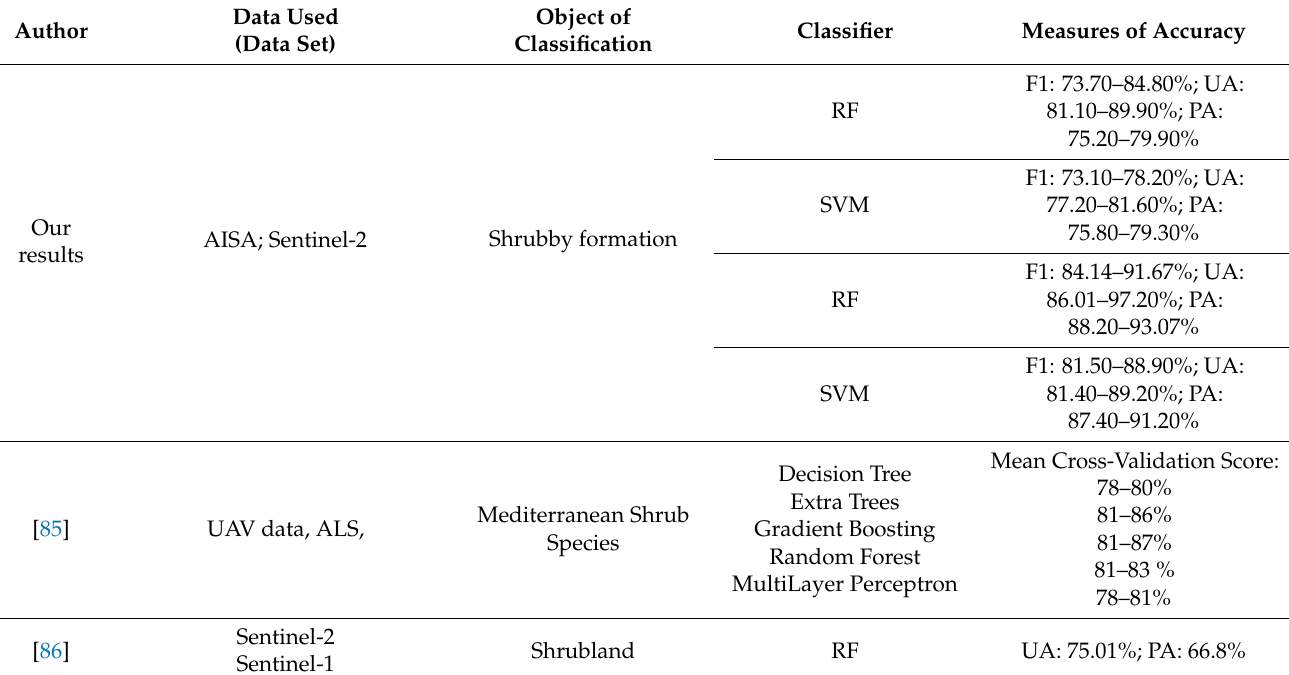
Table 8. Comparison of the obtained results with achievements of other